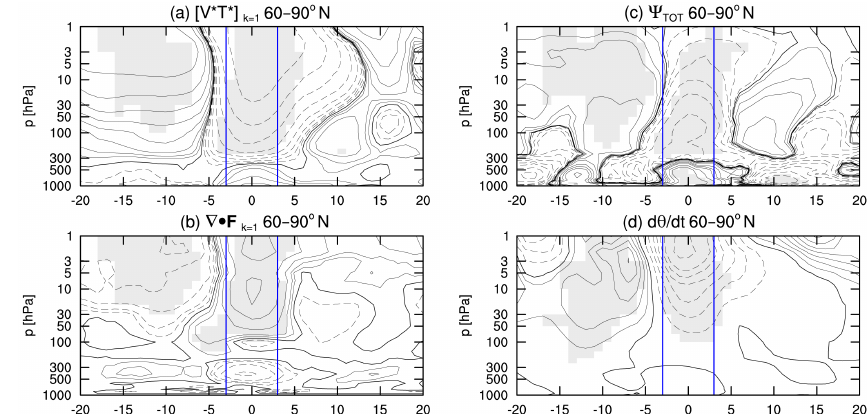
Figure 5. Same as Fig. 1, but from a 100-year CESM1(WACCM) simulation.